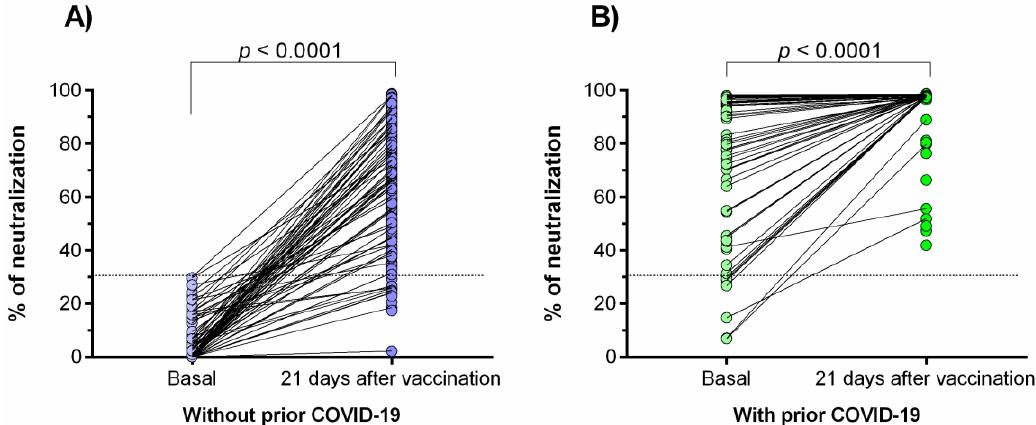
Figure 1. Percentage of neutralizing signal of antibodies generated in response to the Ad5-nCoV vaccine. ( A ) Individuals without prior COVID-19; ( B ) individuals with prior COVID-19. Differences were calculated by the Wilcoxon signed-rank test. The dotted line indicates the cut-off point for the neutralization test (>30%). The “basal” status represents the neutralization percentage before the effect of vaccination (3 days after vaccination).